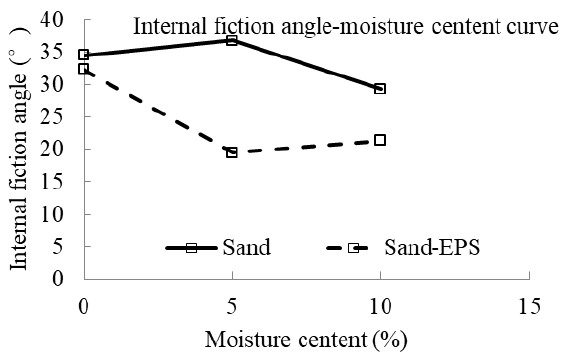
Figure 8. Shear-strength–normal stress curves for different moisture content.